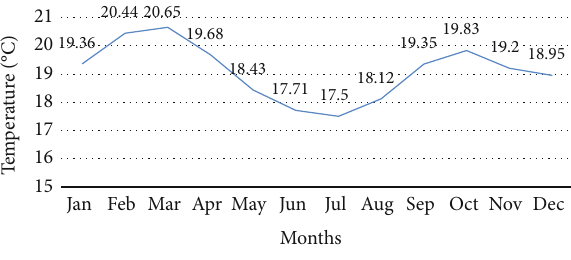
Figure 18: Monthly temperature variation ( ° C) for